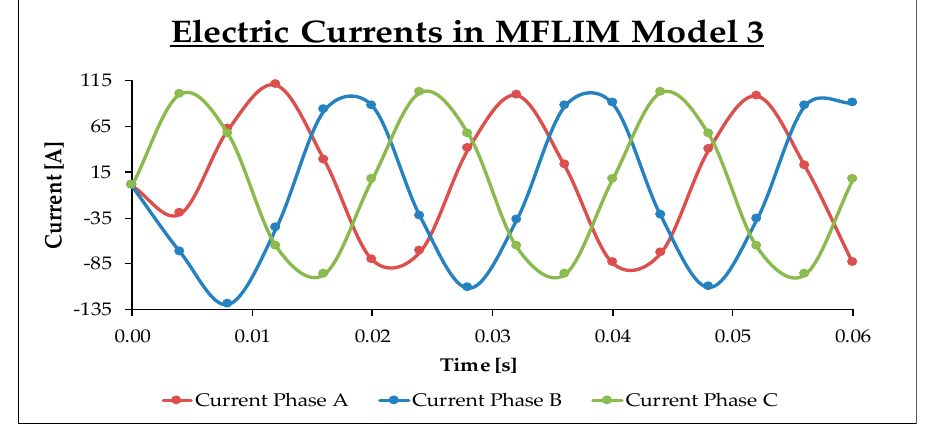
Figure 19. Electric current per phase in model 3.